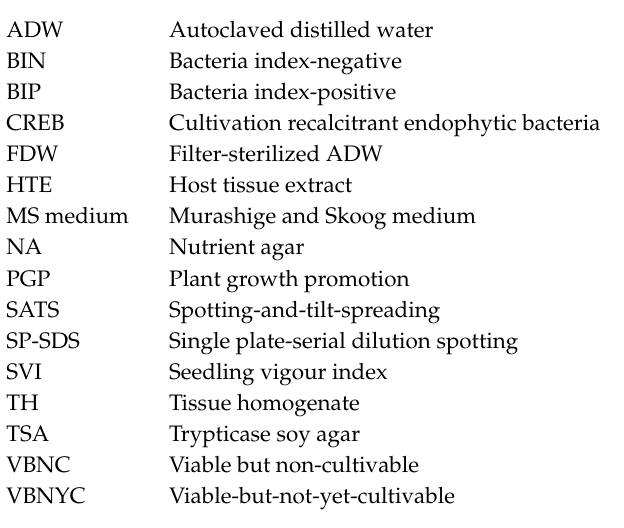
Figure S1. Monitoring the tomato seeds for the e ffi cacy of surface sterilization through di ff erent steps. (a, b) Seed wash solutions of tomato “Arka Vikas” and “Arka Abha” (direct and after Tween-20 step) showing several bacterial colonies on nutrient agar (NA) comprising of Bacillus spp. / spore formers, and (c, d) very few or no colonies after ethanol wash or NaOCl treatment. Figure S2. Tissue homogenate (100 seeds 10 mL − 1 ) from